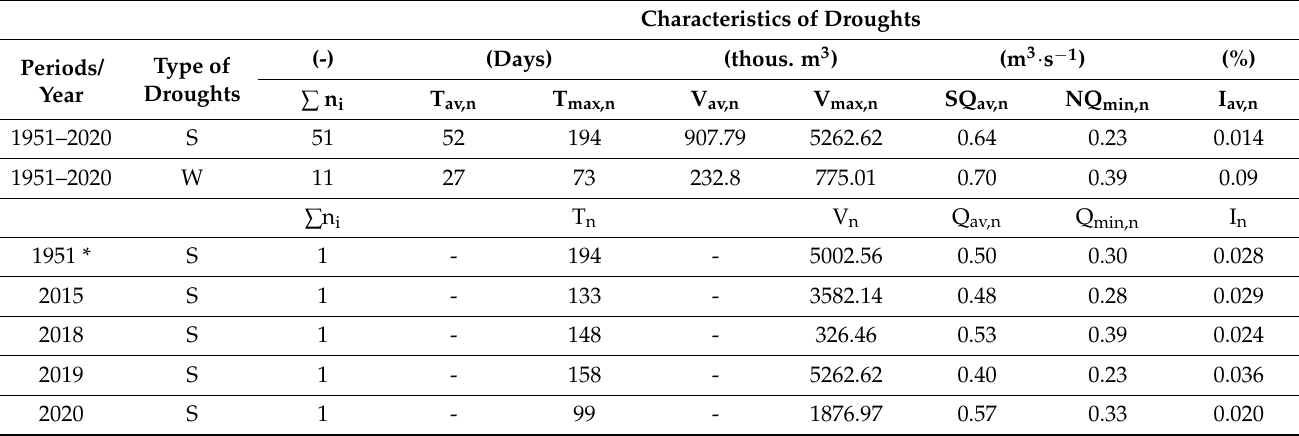
Table 2. Characteristics of streamflow droughts in Narewka River in the period 1951–2020, and streamflow droughts in the years 1951, 2015, 2018, 2019, and 2020.